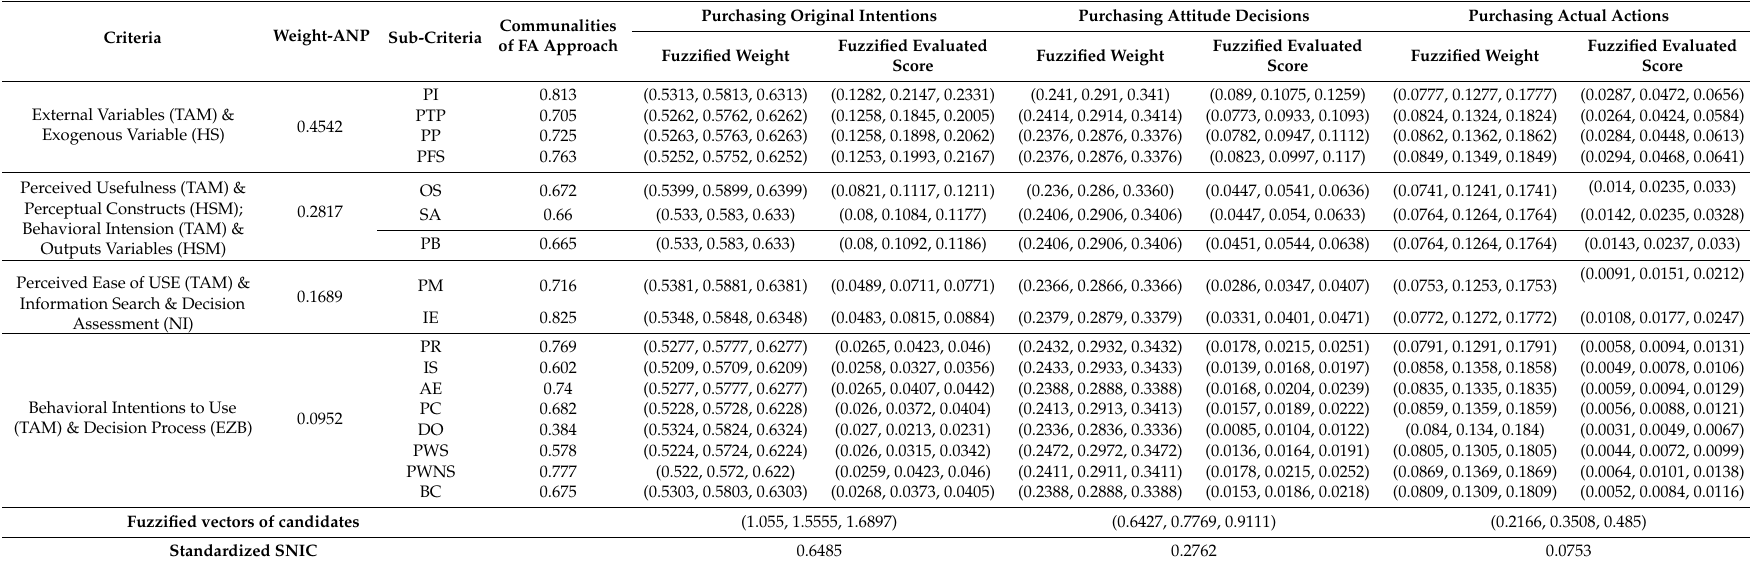
Table 7. The fuzzified standardizing SCIN measurement of